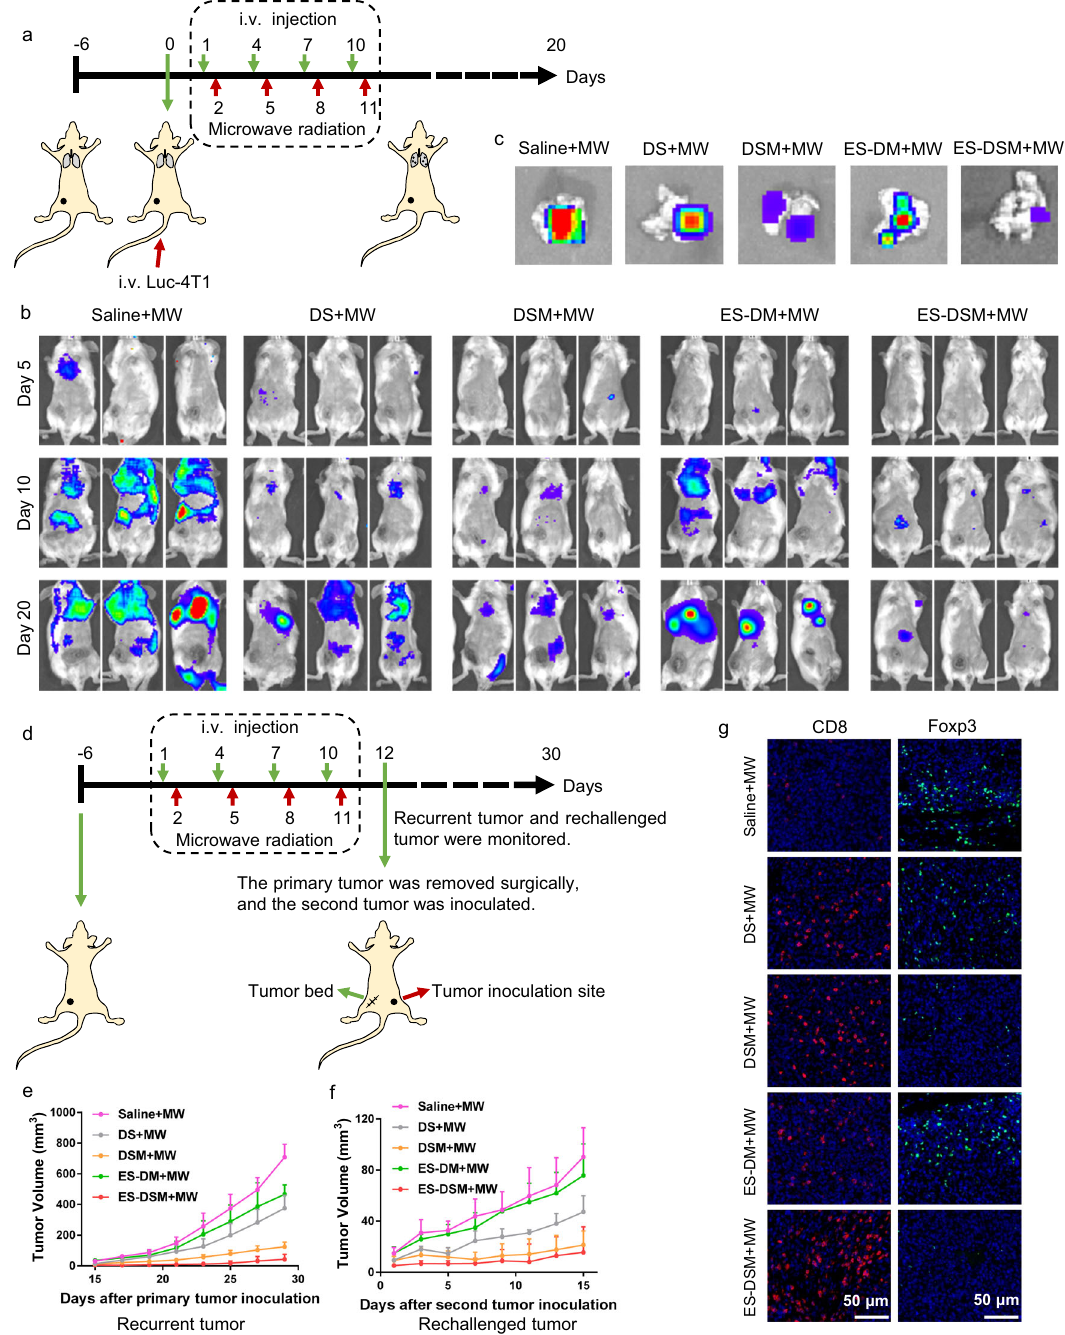
Fig. 8 Observation of pulmonary metastasis and the growth of recurrent and rechallenged tumors. a Schematic of the treatment regimen for the pulmonary metastatic model. b Luciferase bioluminescence images of Luc-4T1 pulmonary metastatic tumor during the treatments ( n = 3). c Representative luciferase bioluminescence images of lungs on day 20 after different treatments. d Schematic of the treatment regimen for the recurrent and rechallenged tumor models. Curves showing volumes of e recurrent and f rechallenged tumors of mice after various treatments ( n = 5, data are presented as mean values ± SEM). g Immuno fl uorescence was used to examine CD8 + T cells and Foxp3 + T cells in rechallenged tumor sections at the end of the observation period. The experiments in g showed similar results in three independent mice. DS: free DOX and SCH; DSM: DOX and SCH co-loaded micelles; ES-DSM: E-selectin-modi fi ed co-loaded micelles; ES-DM: E-selectin-modi fi ed DOX-loaded micelles; MW: microwave radiation (8 W, 30 min). Source data are provided as a Source data fi